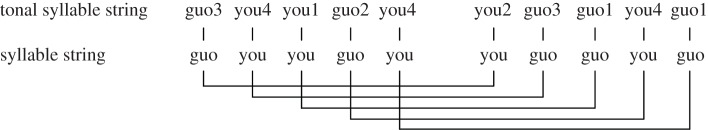
An example of grammatical strings in Experiment 3. Unlike Experiments 1 and 2, the inversion rule used in Experiment 3 was defined over the syllables of Chinese language. Specifically, the syllables (‘guo’ or ‘you’) of the first five tonal syllables of a string predicted those of the last five by an inversion relation (i.e. the syllable ‘guo’ mapped to the syllable ‘you’). For example, if the syllable of the first tonal syllable was ‘guo’, then the syllable of the sixth tonal syllable was ‘you’, and if the syllable of the second tonal syllable was ‘guo’, the tone type of the seventh tonal syllable was ‘you’, and so on.